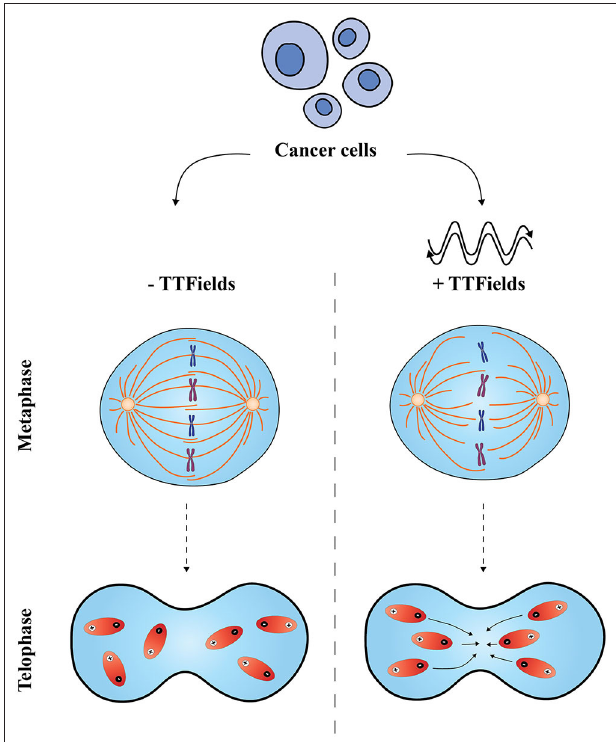
FIGURE 1 | Proposed effects of Tumor Treating Fields on cancer cells. The application of TTFields is believed to disrupt two distinct phases in the mitotic process. In metaphase, TTFields interfere with the mitotic spindle assembly and disturb the alignment of tubulin subunits; in telophase, non-uniform electric fields cause a change in the cell shape and conformation, and compromise polar elements (shown in red) which move to the cleavage furrow leading to an impaired cell division (right-hand side). Normal metaphase and telophase are shown on the left-hand